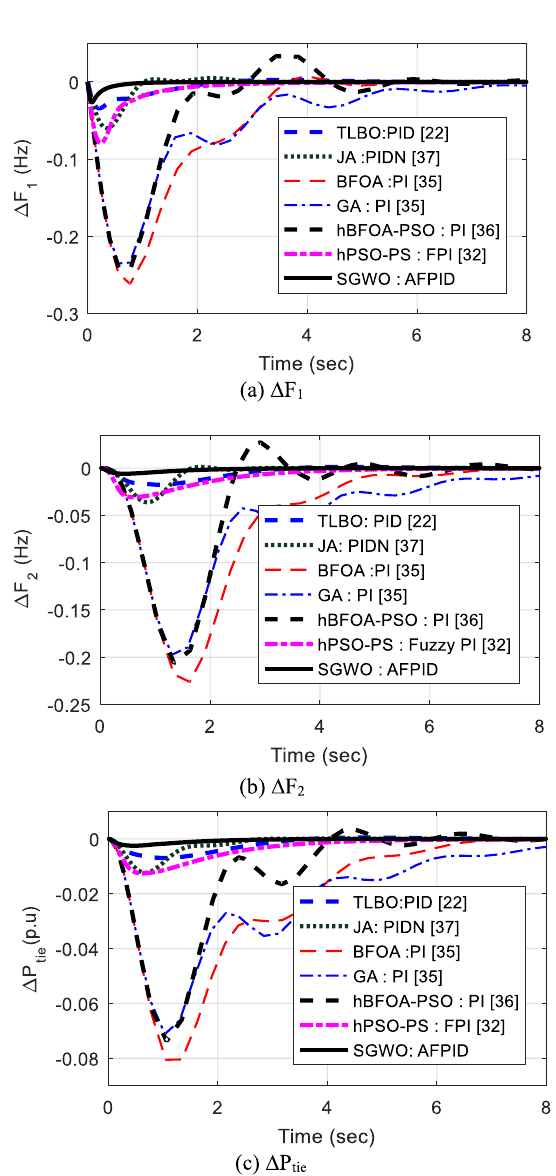
Fig. 14 System frequency deviation response for two